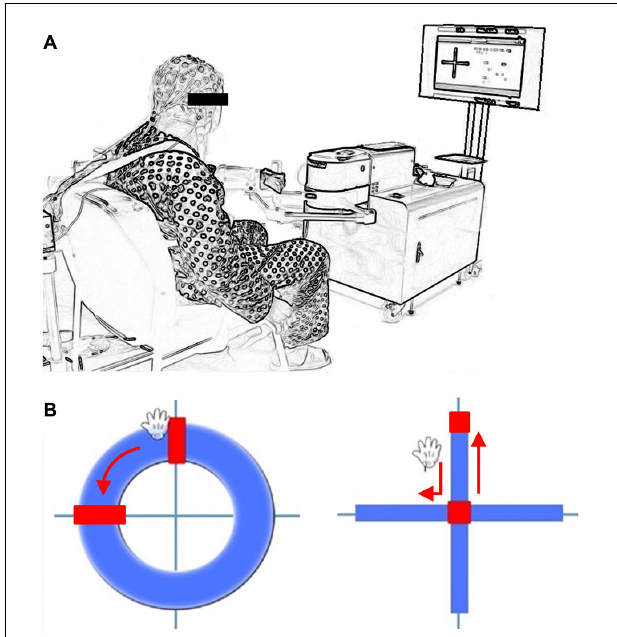
FIGURE 1 | (A) Cognitive-Upper Limb Motor dual task test setup (3DBT-63, Man&Tel Inc., Gumi, South Korea) (B) Visual feedback with movement cursor and direction indicator (Circle and Cross movement